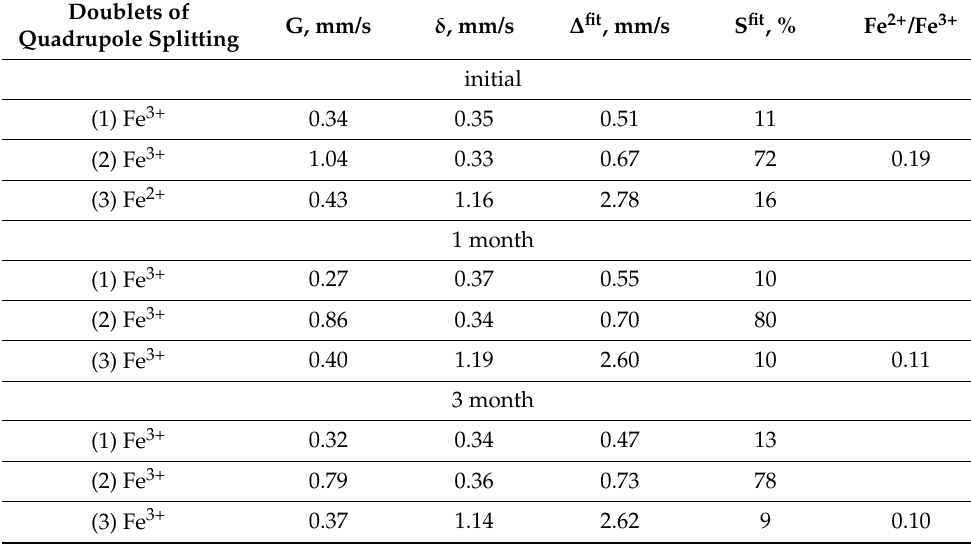
Table 7. Parameters of Mössbauer spectra obtained for the bentonite samples. Doublets of Quadrupole